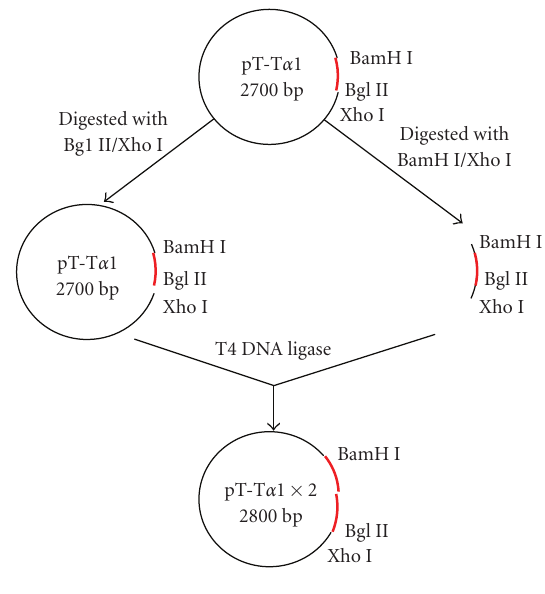
Figure 1: The complete amino acid sequence of T α 1.